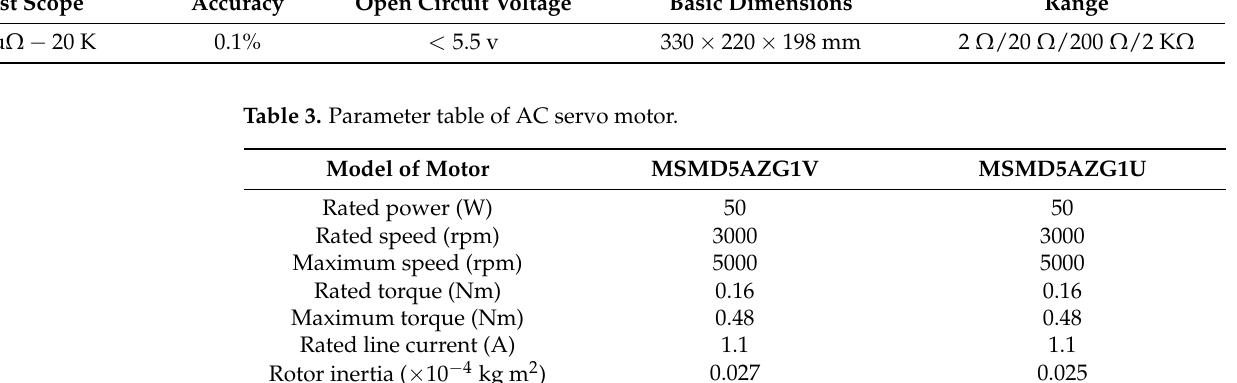
Table 2. Relevant parameters of RK2511n + DC resistance tester.